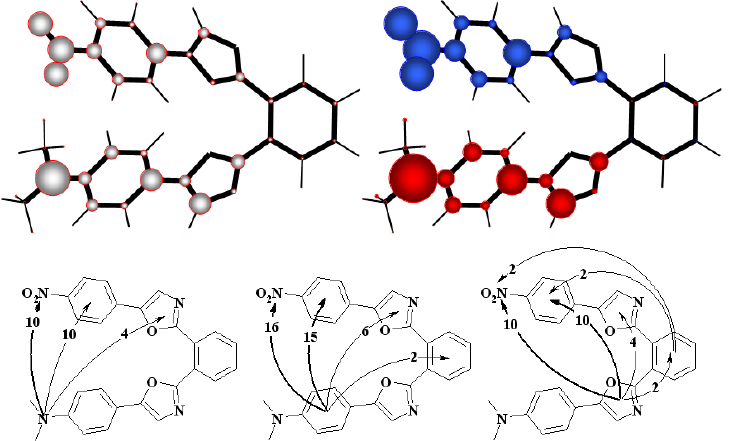
Figure 1. The ESS-analysis applied to the long-wavelength electronic transition in the absorption spectra of compound I (ground state optimized molecular geometry): localization of the electronic excitation (gray circles with radii proportional to localization numbers [27]), net charge changes (blue circles for increase of the electronic density, red – for increase of the positive charge) and arrow diagrams showing the main pathways for the electronic density movement at the electronic excitation S